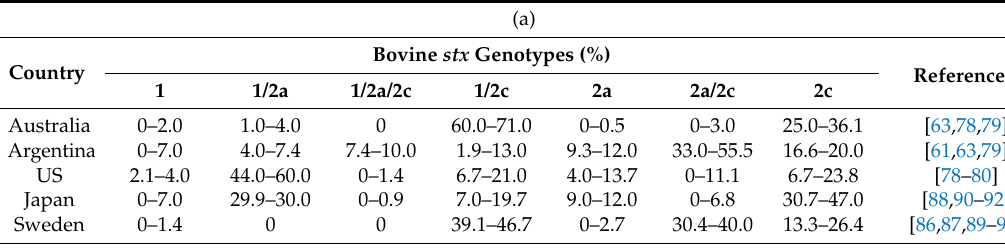
Table 4. Values (or interval of values from different sources) of stx -genotype frequencies in (a) bovine E. coli O157 strains isolated in different